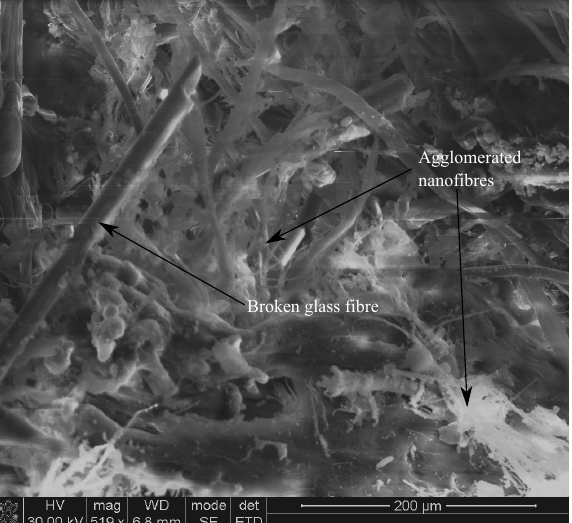
Figure 8. Agglomerated nanofibers of 1 wt% RONFs mats strengthened hybrid